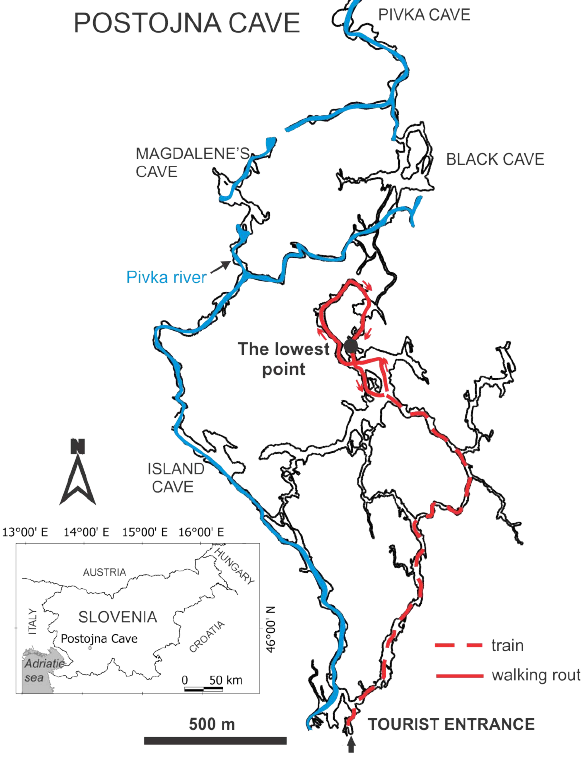
Fig. 1. Map of the Postojna Cave system showing the cave railway, walking route and the lowest point (our measurement